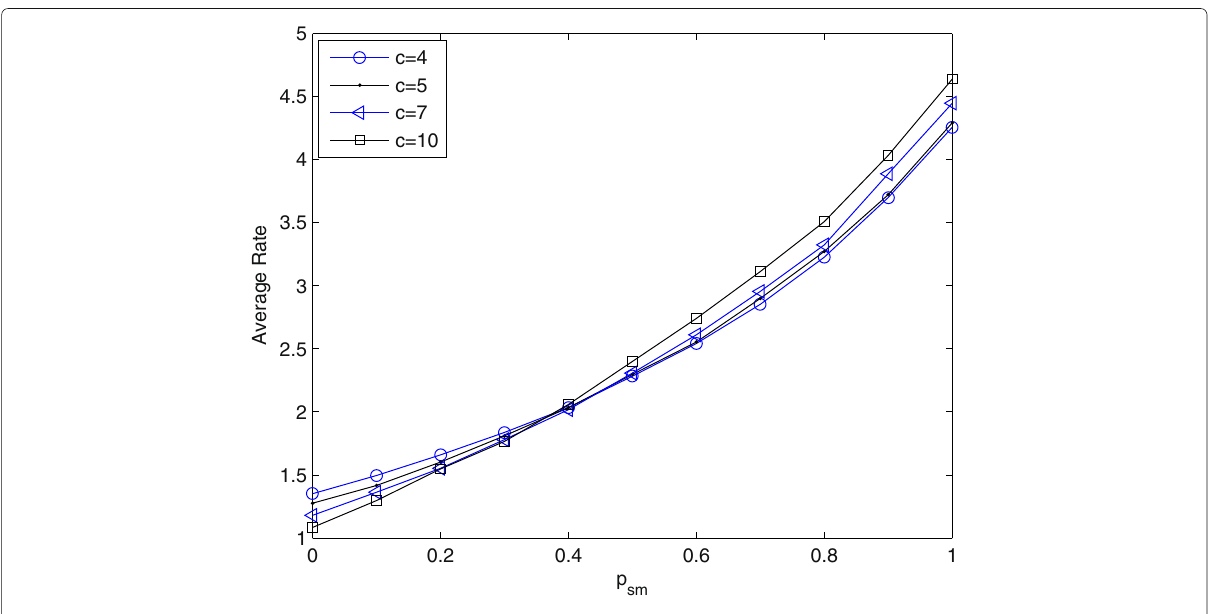
Fig. 7 Average achievable rate vs. the mmWave probability p sm